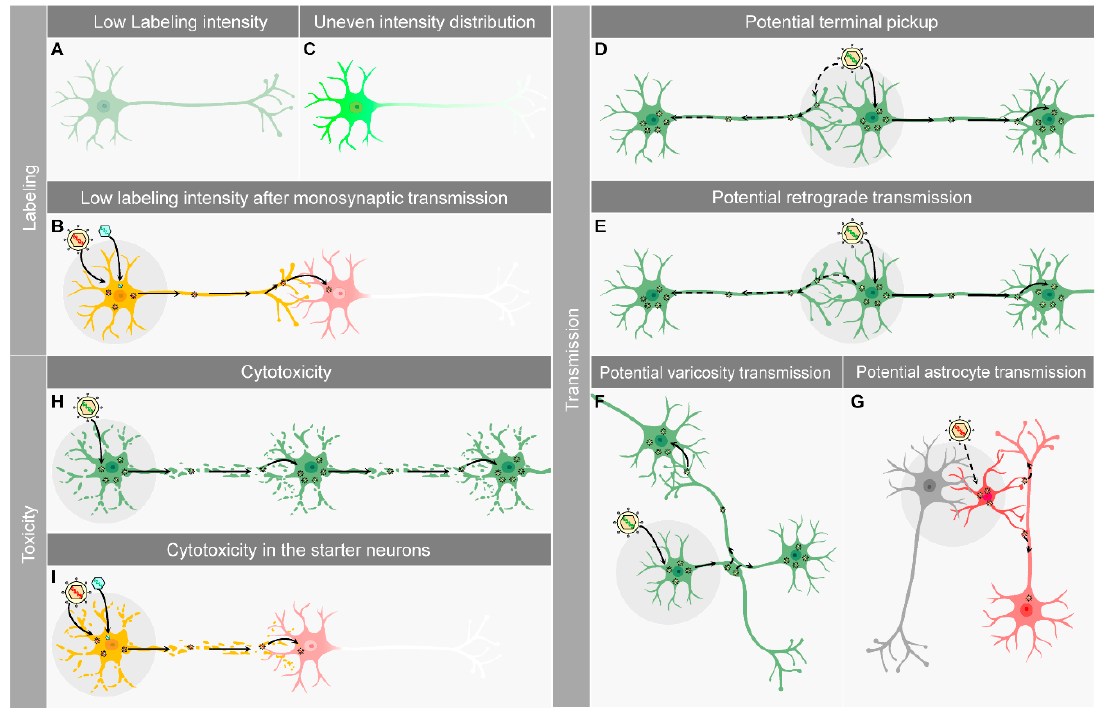
Figure 2. The limitations of current H129-derived tracers. ( A – C ). Limitations of labeling intensity. ( A ) Some tracers label the neurons with relatively low intensity. ( B ) Current monosynaptic tracers do not replicate after monosynaptically transmitting to postsynaptic neurons. Labeling intensity in second-order neurons is very low, making the neurites invisible even after immunostaining. ( C ) The labeling intensity of the entire neuron is not evenly distributed. The soma is labeled much more brightly than the neurites, resulting in axon and axonal terminals that are difficult to observe or even invisible. ( D – G ). Limitations of the tracer transmission. ( D ) H129-derived tracers mainly invade the neuron from the soma and transmit further (solid arrow). However, they can also be potentially picked up by the axonal terminal of the upstream neurons (dashed arrows), and label them with the fluorescent protein. ( E ) Besides the predominant anterograde transmission (solid arrows), H129-derived tracers were reported to potentially transmit retrogradely and label upstream neurons (dashed arrows). ( F ) H129 may potentially transmit to adjacent neurons from varicosity (indicated as the enlarged region of the axon) (dashed arrows). ( G ) H129 may potentially infect astrocytes. In astrocytes, H129-dTK may replicate in the absence of helper virus, and the progeny virions may transmit to adjacent neurons (dashed arrows). ( H , I ). Limitations of cytotoxicity. ( H ) The polysynaptic tracers (indicated by the enveloped virion with green genome) are replication-competent. Their anterograde transmission requires tracer replication and progeny production. The viral replication causes severe damage or even neuron death (indicated by the cracks). ( I ) Monosynaptic tracers (indicated by the enveloped virion with red genome) are replication-deficient in the absence of a helper virus. Due to replication deficiency, only a few viral proteins are synthesized, leading to less damage to the cells. Therefore, they show attenuated toxicity to the postsynaptic neurons after monosynaptic transmission (the red neuron). However, under the assistance of the helper virus (indicated by the unenveloped virion with green genome), H129-derived monosynaptic tracers replicate in the starter neurons (the yellow neuron) and cause severe damage to the starter neurons (indicated by the